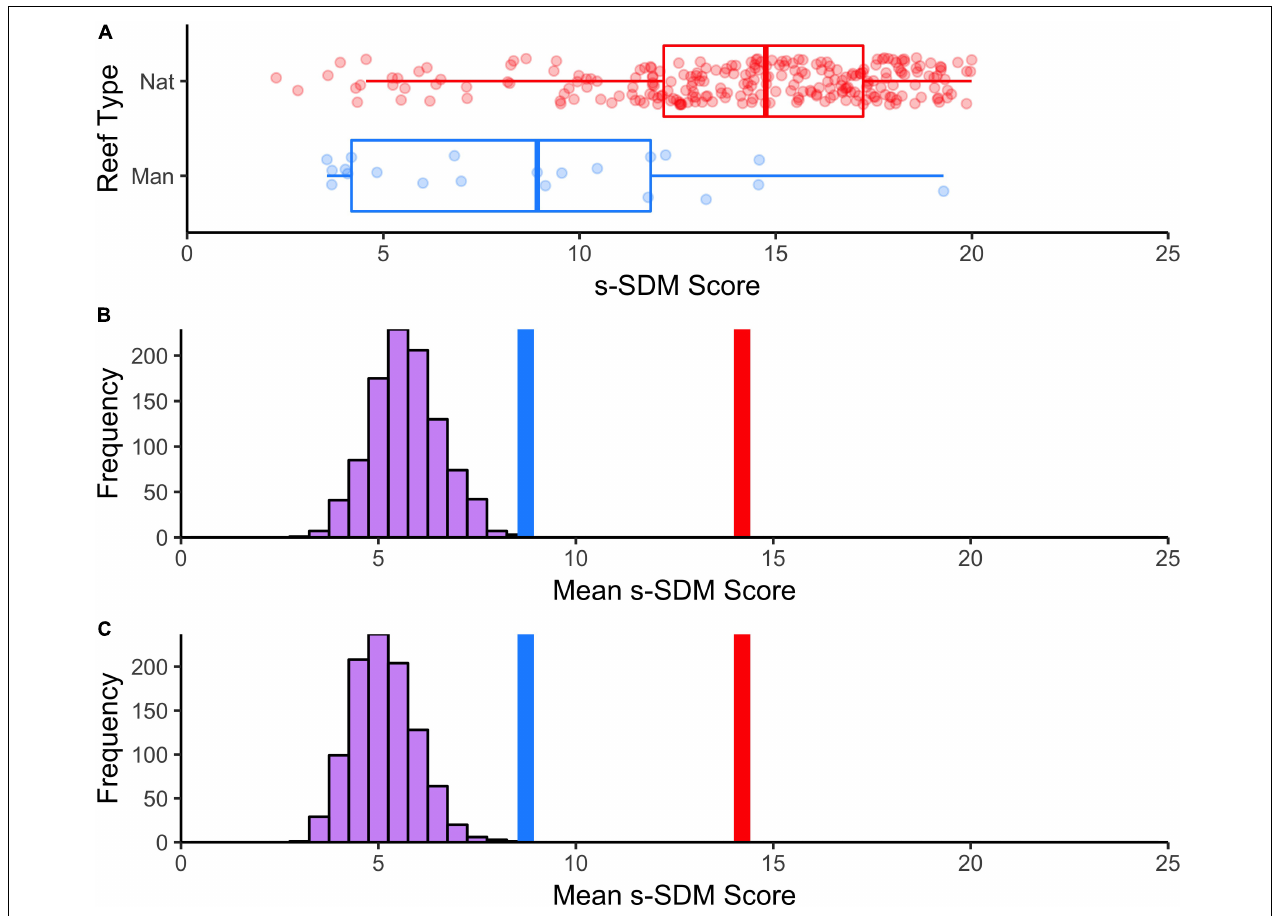
FIGURE 5 | Mean s-SDM scores of existing manmade reefs relative to natural reefs and compared to random. (A) Boxplot of differences in s-SDM scores for natural (blue) and manmade (red) reef sites. Mean s-SDM score was calculated for the already existing solitary manmade reefs within the SCB ( n = 21, blue line) and for each of the natural reef sites ( n = 250, red line). The means were compared to a permuted distribution of 21 randomly selected sites iterated 1000 times. (B) Random sites chosen from anywhere in the SCB. (C) Random sites chosen from only areas with no existing